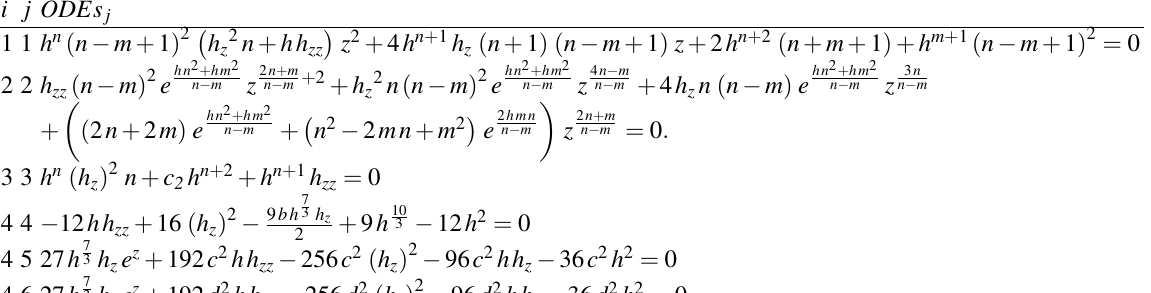
Table 4: Reduced ODEs: i j ODEs